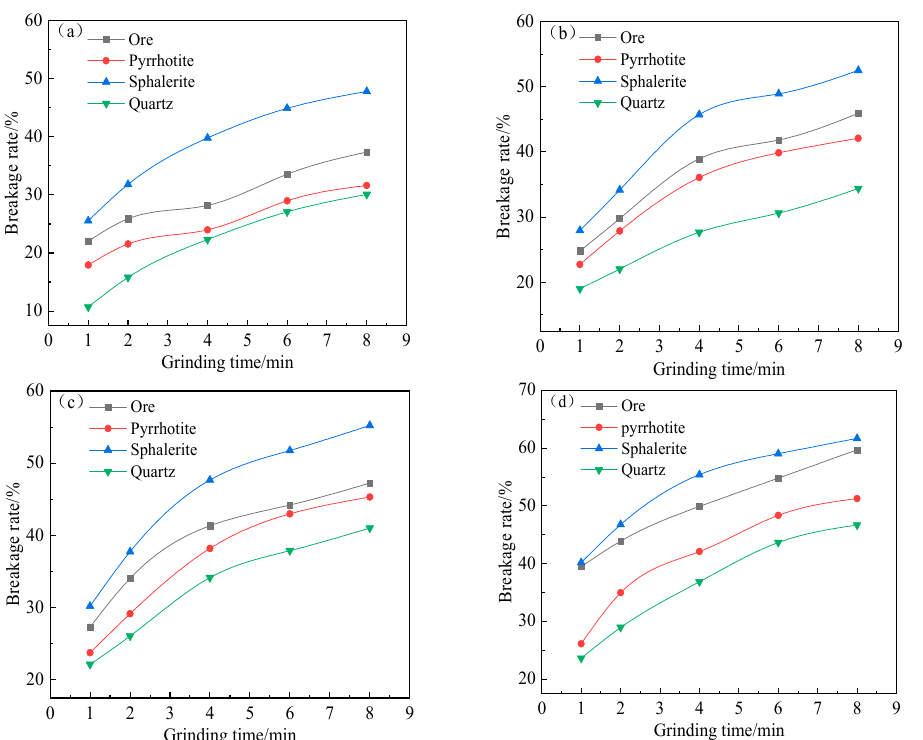
Figure 4. Comparison of the relationship between breakage rate and grinding time for ore and component minerals ( a ) − 4.75 + 3.36 mm, ( b ) − 3.35 + 2.36 mm, ( c ) − 2.36 + 1.70 mm, ( d ) − 1.70 + 1.18 mm.